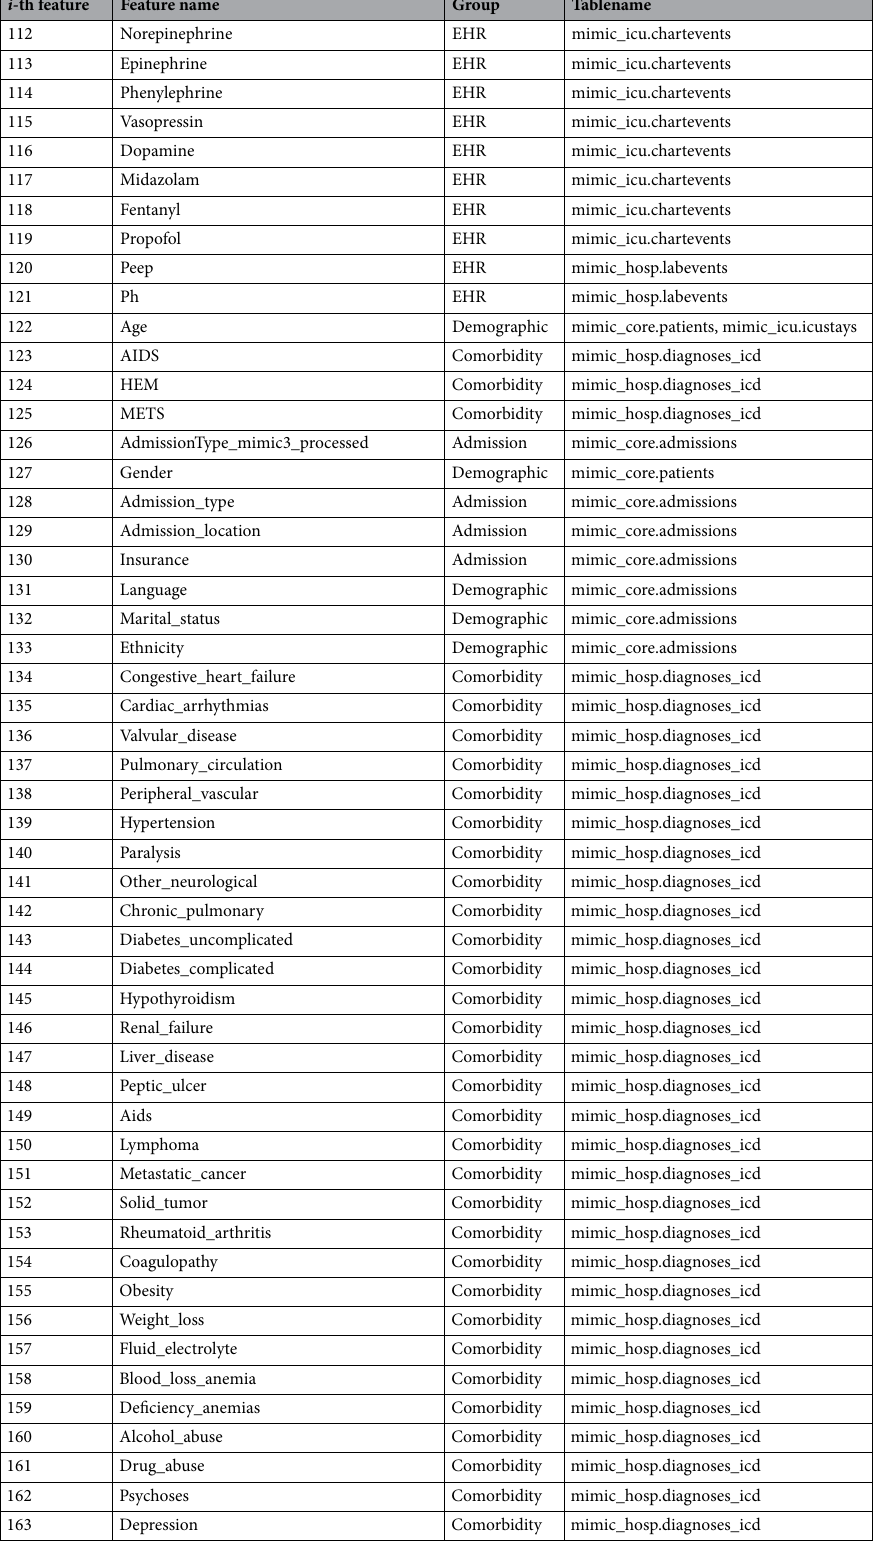
Table 8. Full list of selected 164